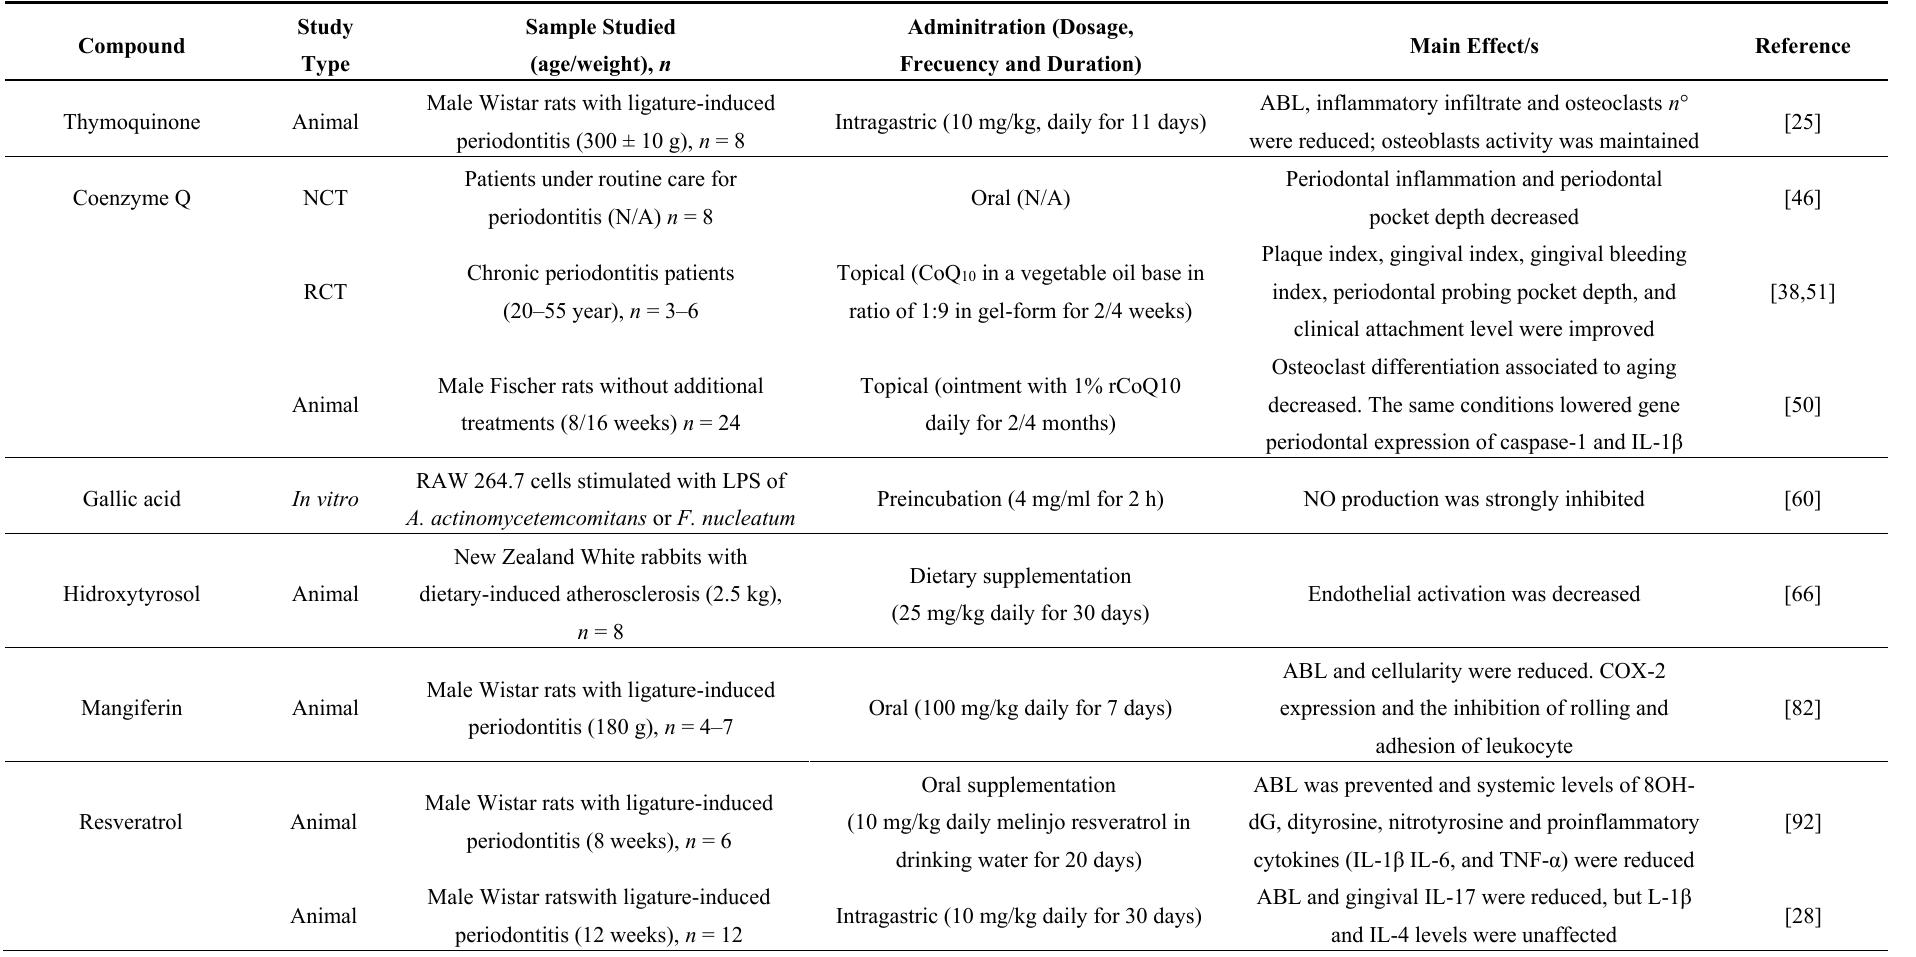
Table 1. Main studies in relation to naturally occurring antioxidant phenolic compounds of interest in periodontal